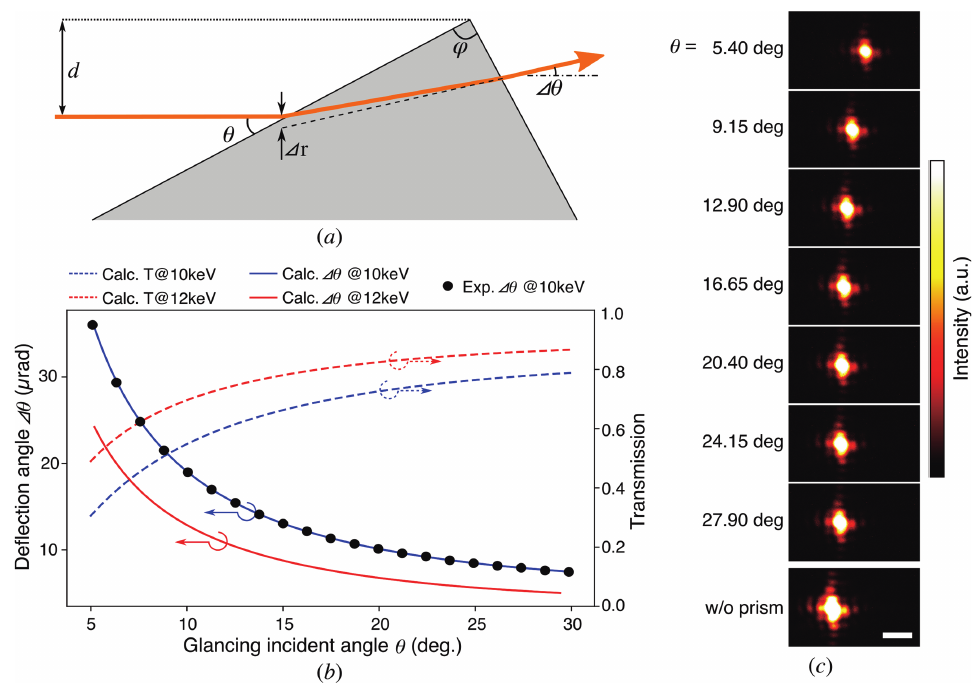
Figure 2 Schematic and performance of an X-ray prism. ( a ) A schematic of an X-ray prism and the trajectory of a deflected X-ray beam. ( b ) Incident-angle dependence of the deflection angle and transmission of the prism. The solid blue (red) line indicates the calculated deflection angle at a photon energy of 10 keV (12 keV). The dashed blue (red) line indicates the calculated transmission at 10 keV (12 keV), when the incident-beam width is 0.6 mm (see the supporting information). The black dots indicate the deflection angles examined by the experiment. ( c ) Images of the deflected X-ray beams while the incident angle to the prism was varied from 5.4 to 27.9 (cid:4) . The bottom image shows the result without the prism. The scale bar denotes 30 m